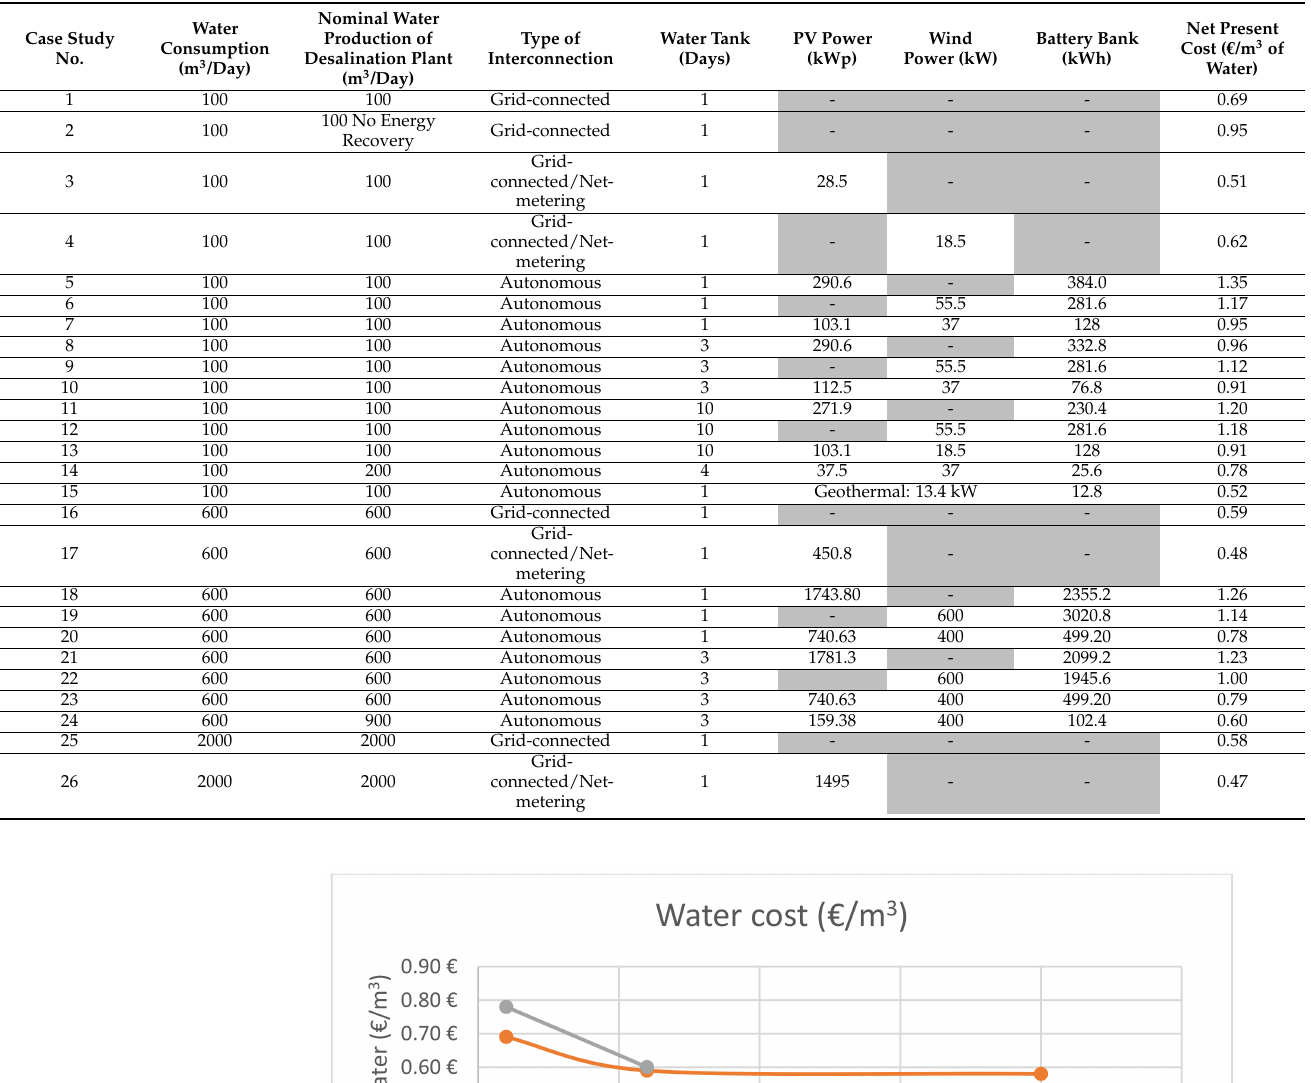
Table 3. Optimization results.